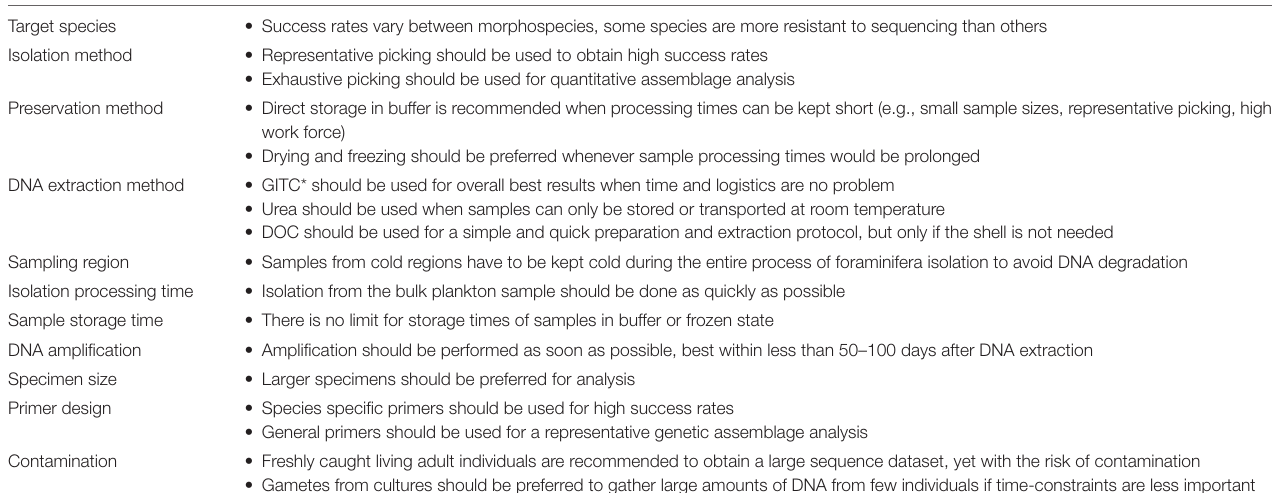
TABLE 1 | Factors influencing DNA amplification success rates and recommendations for successful single-cell genetic analysis of planktonic